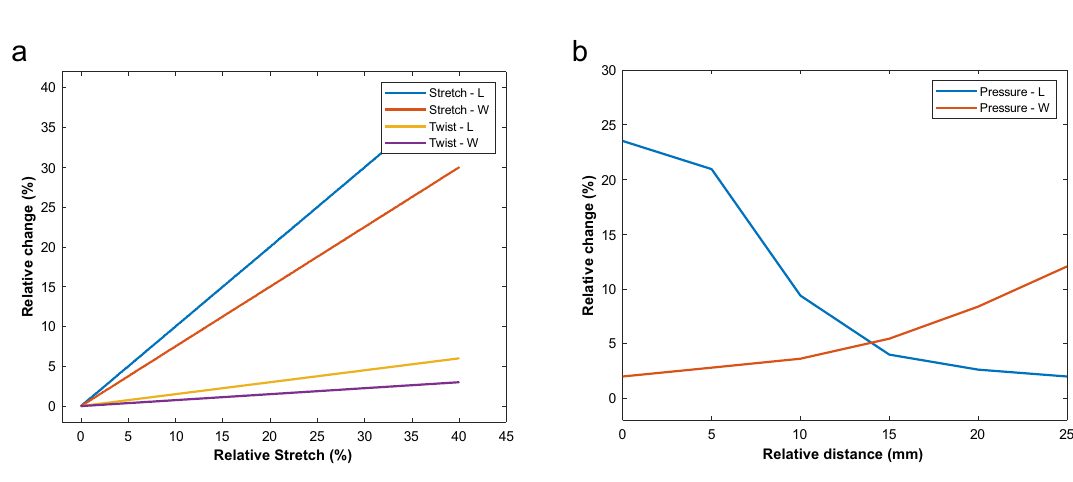
Figure 12. Response of the sensor Type-2 to ( a ) stretch, twist, and ( b )